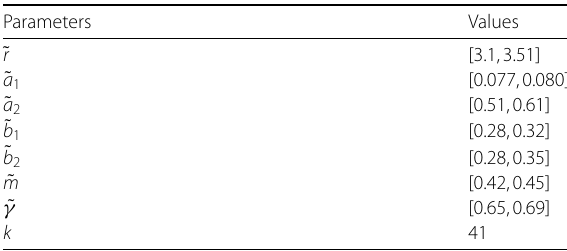
Table 7 The values of different parameters used to simulate the model system in Cases IV, V, and VI